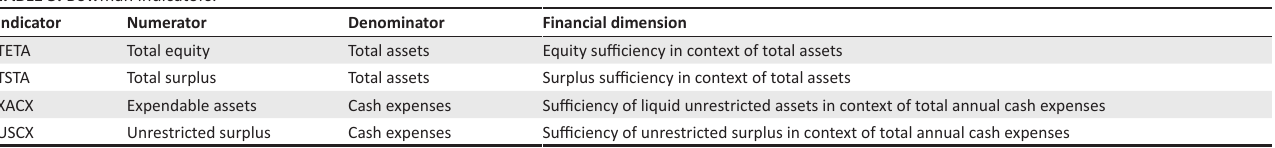
TABLE 3: Bowman indicators.